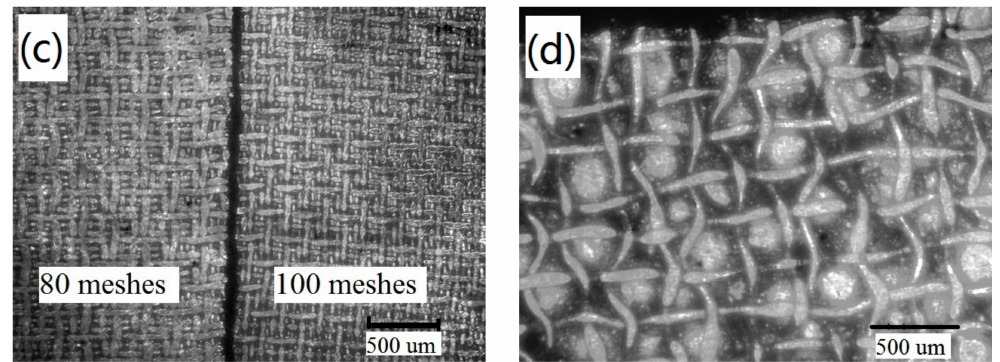
Figure 2. ( a ) The structure of the wire mesh with the 100 mesh-screen; ( b ) the appearance of the WMPPs; ( c ) the pore and skeletal structures of the WMPPs with different wire meshes; and, ( d ) the pore and skeletal structures of the WMPP made by wire mesh and powder.